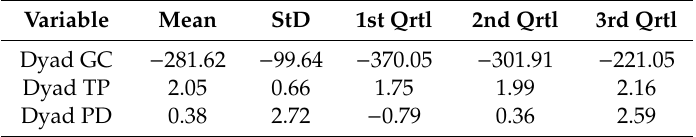
Table 2. Descriptive statistics, Study